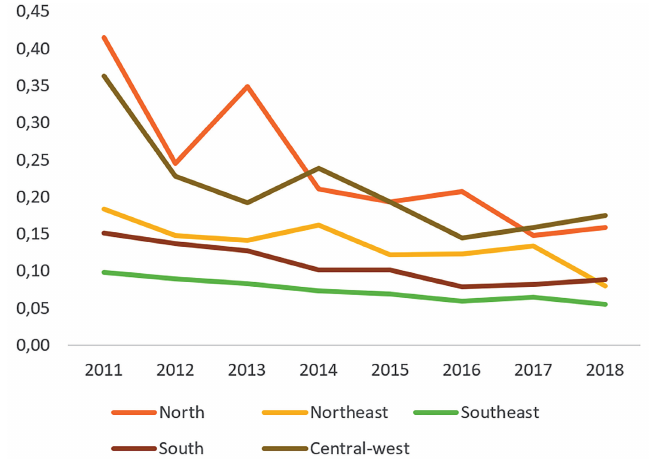
Figure 7 - Cystectomy over TURb Rate from 2008 – 2017 according to geographic regions in